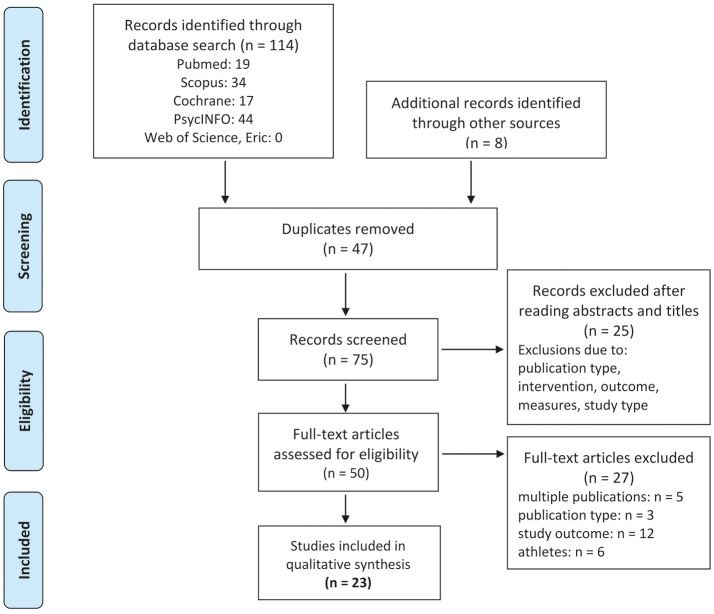
Flow diagram of search process according to PRISMA (Moher et al., 2010).